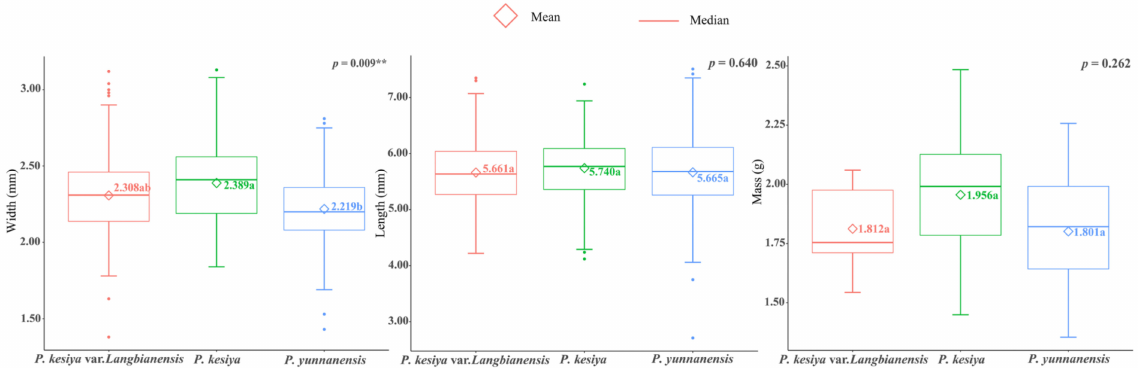
Figure 2. Comparison of seed morphology between the P. yunnanensis , P. kesiya, and P. kesiya var. langbianensis populations. Significant differences are indicated by asterisks (** p < 0.01). Different lowercase letters indicate significant differences (Tukey’s HSD mean separation